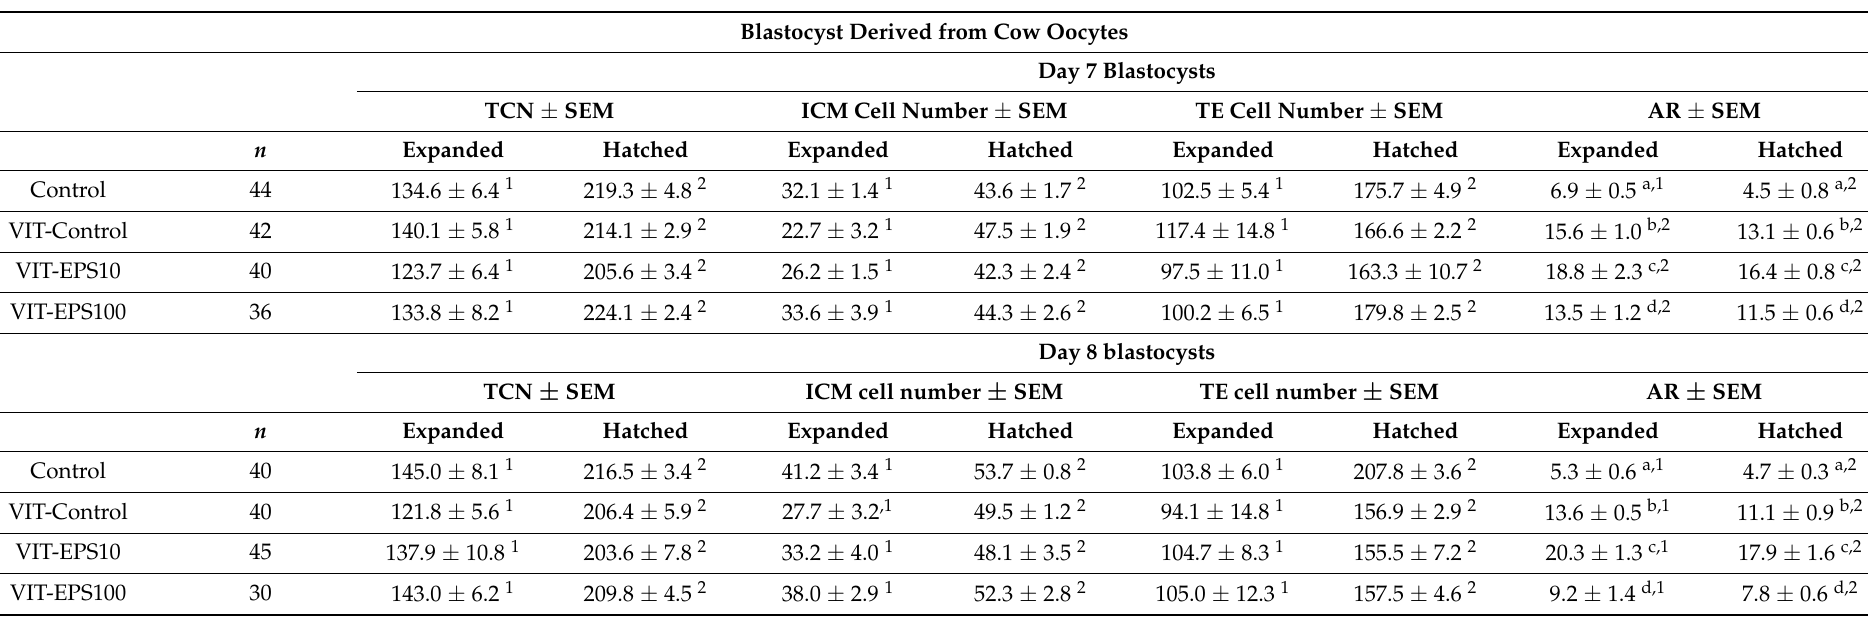
Data are shown as mean ± SEM. a,b,c,d Values within columns with different superscripts indicate significant differences between treatments ( p ≤ 0.05); 1,2 Values within rows with different superscripts indicate significant differences between stages (Expanded and Hatched) ( p ≤ 0.05). TCN: Total cell number; ICM: Inner Cell Mass; TE: Trophectoderm; AR: Apoptosis rate. Control: fresh non-vitrified expanded blastocysts; VIT-Control: blastocysts vitrified/warmed without EPS ID1 supplementation; VIT-EPS10: blastocysts vitrified/warmed with 10 µ g/mL EPS ID1 supplementation; VIT-EPS100: blastocysts vitrified/warmed with 100 µ g/mL EPS ID1